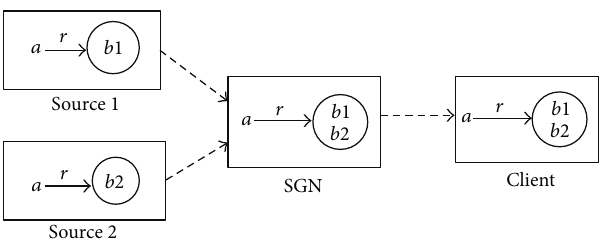
Figure 4: The integration process of the forward composition.